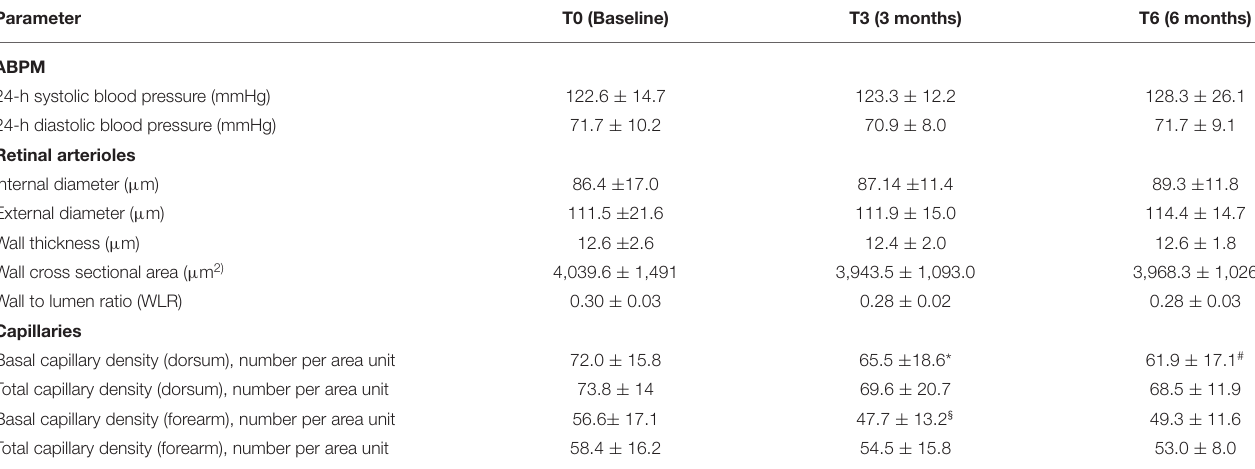
TABLE 3 | Blood pressure values and indices of microvascular structural alterations at the different time points.